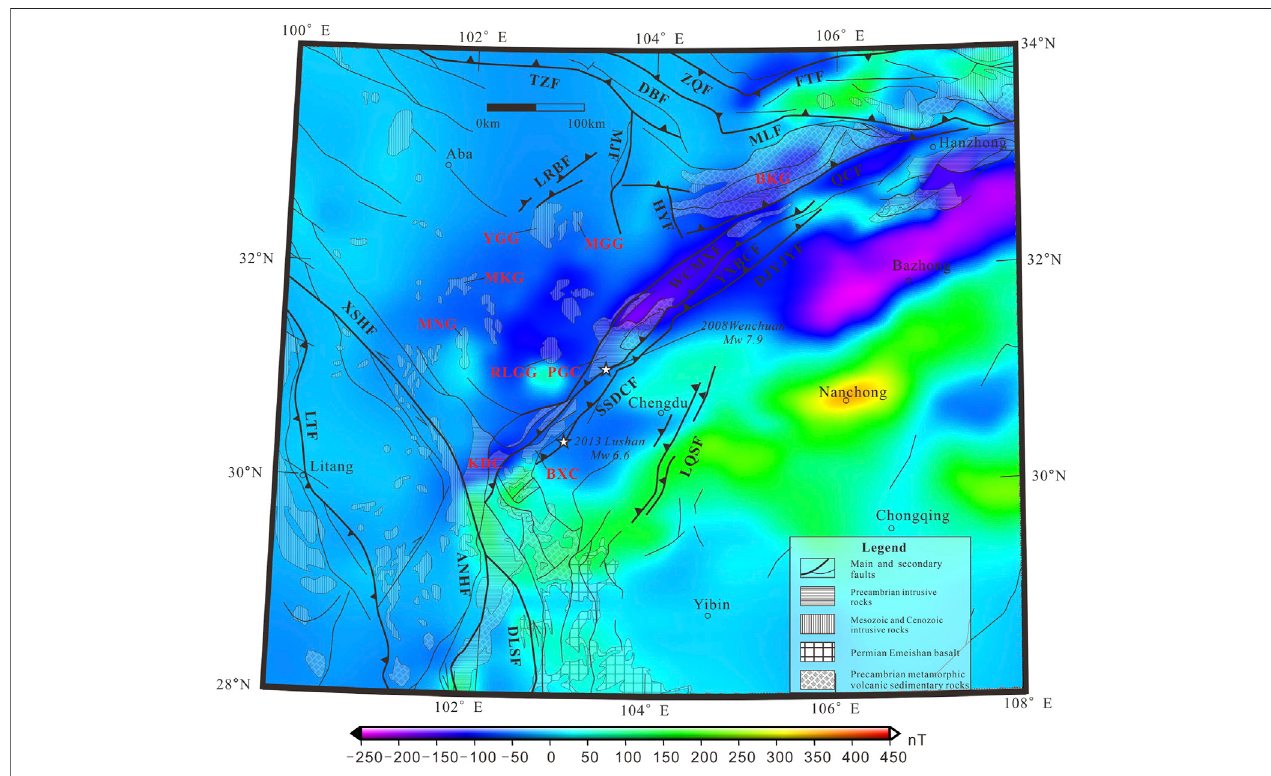
FIGURE3| Magneticanomaly(EMAG2-v3)in Longmenshanregion at altitude of4 kmwithresolution oftwoarc-minutes. The geological base map isthe same as Figure 1 .